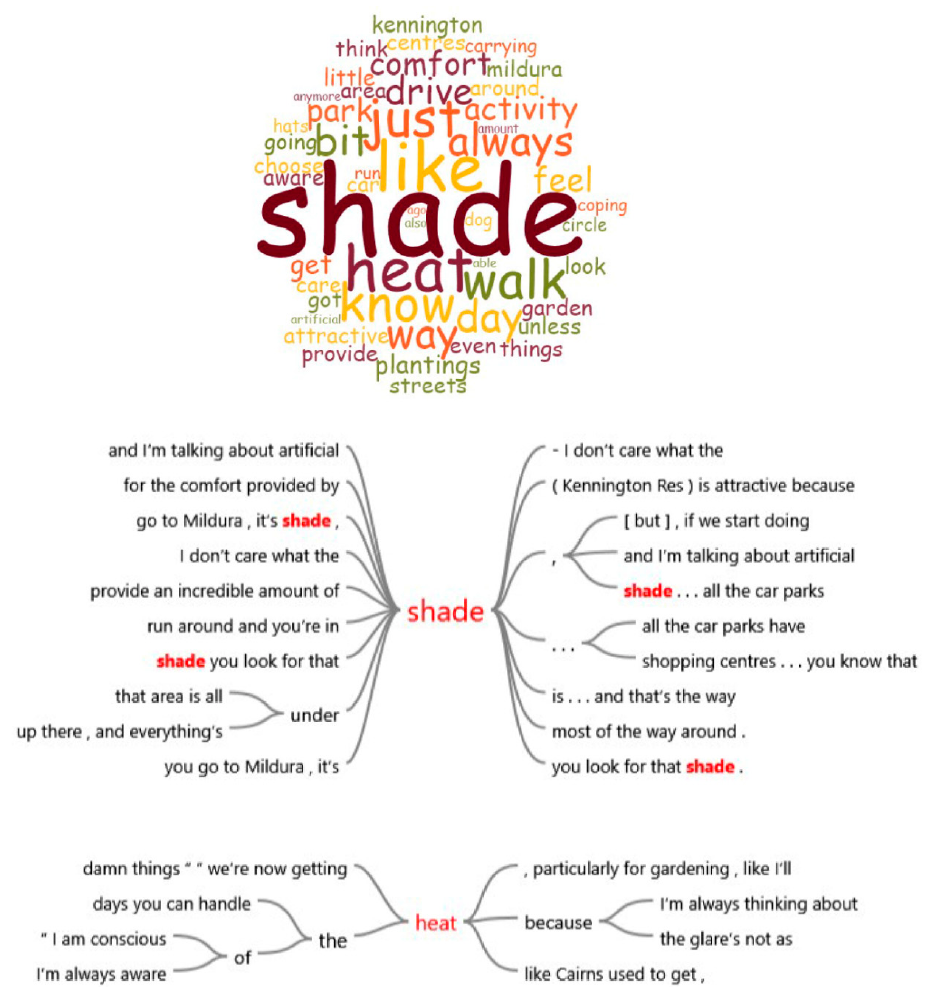
Figure 4. Word cloud and word tree visualization derived from the participants’ opinions.